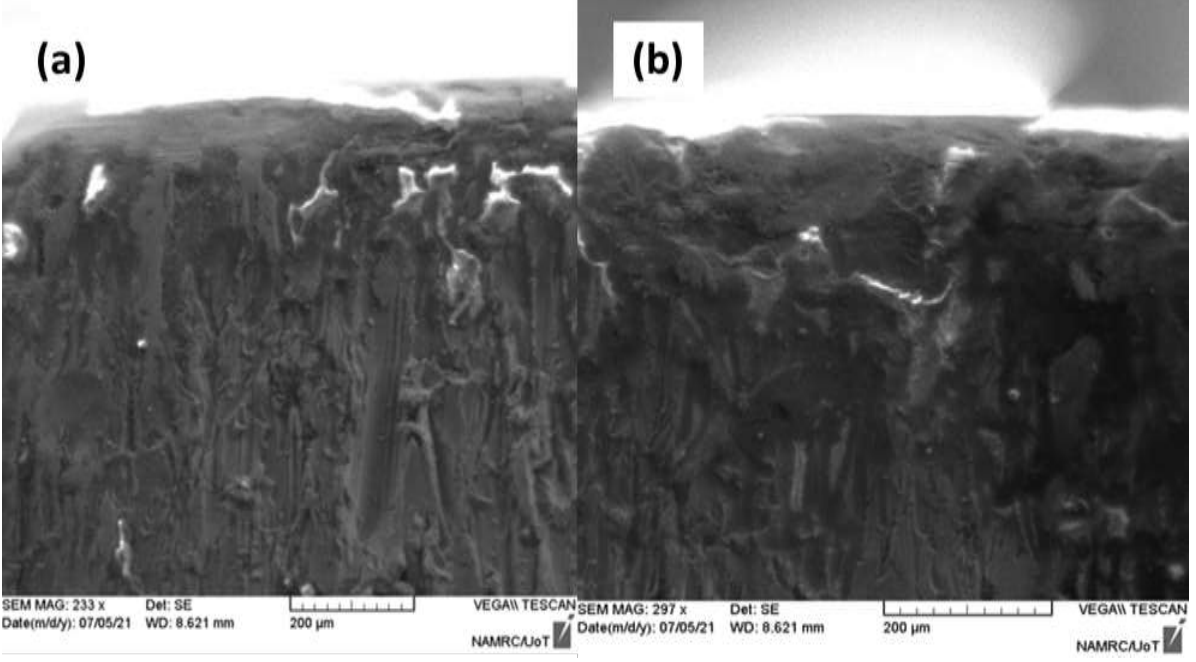
Figure 4: SEM cross - section image for HSLA steel coated with Zn layer in (a) and nitrided + Zn coated in